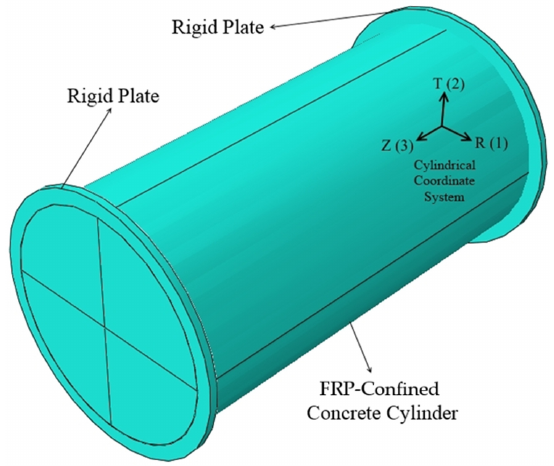
Figure 1. Geometry of the FE model.